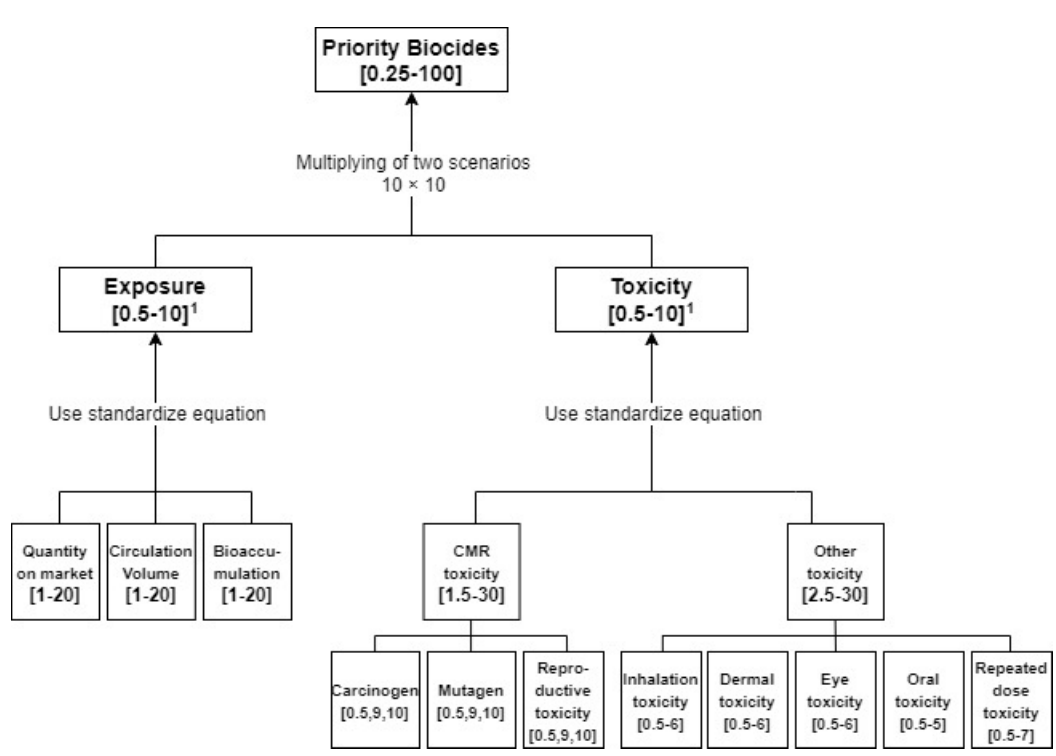
Figure 2. The method diagram of biocide health risk priority ranking. 1 The scaled score to yield values between 0.5 and 10.